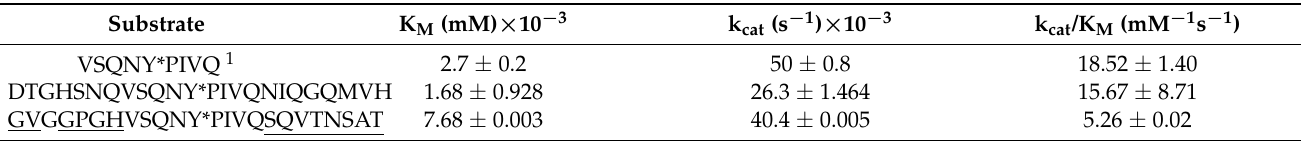
Table 3. Kinetic parameters determined for HIV-1 PR. For the measurements, the His 6 -MBP-mApple substrates representing wild-type and modified 24-residue-long cleavage sites were applied. The modified residues of HIV-1 MA/CA cleavage site are underlined. 1 For comparison, values determined previously for wt-9res substrate are also shown [13].